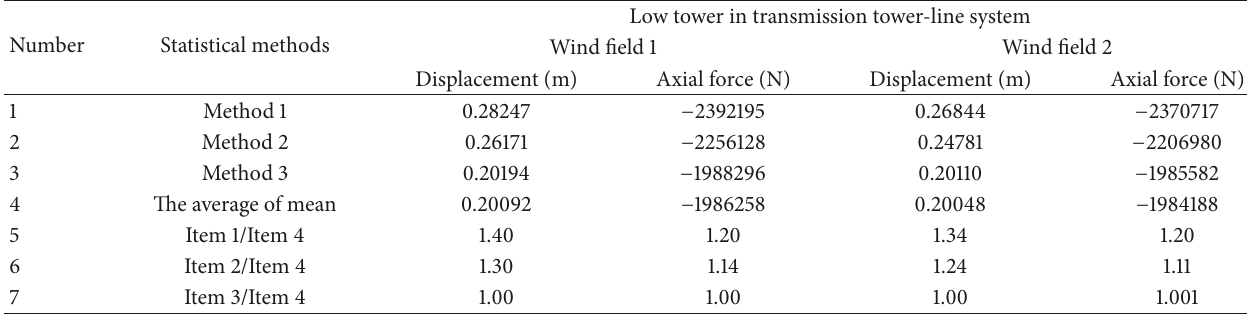
Table 25: Comparison of statistical results on low tower in the system node 874# Ux displacement and element 3986# axial